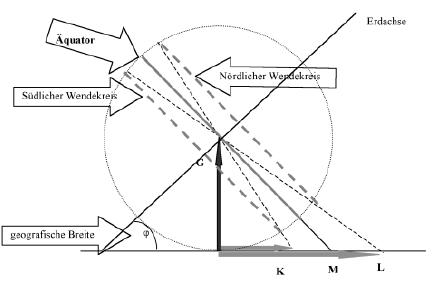
Figure 10: Principle of the gnomon (shadow staff) The picture shows a model of the earth. The tip of the gnome G is located in the center of the earth, the 3 lines to K, M and L mark the direction of incidence of the sun rays to summer, spring (or autumn) - and winter begins. The line to M marks the 10 "Anyone who might feel disappointed by Euler's" expert opinion "must be aware that nothing better was possible simply because of the Pliny text." The problem was only after the "hard bone work" of the archaeologists (Edmund Buchner) - discovery and exposure of the parts of the dial - to master and finally solve with the help of Gnomonic means Euler did not live to see this great moment of 1980/81.